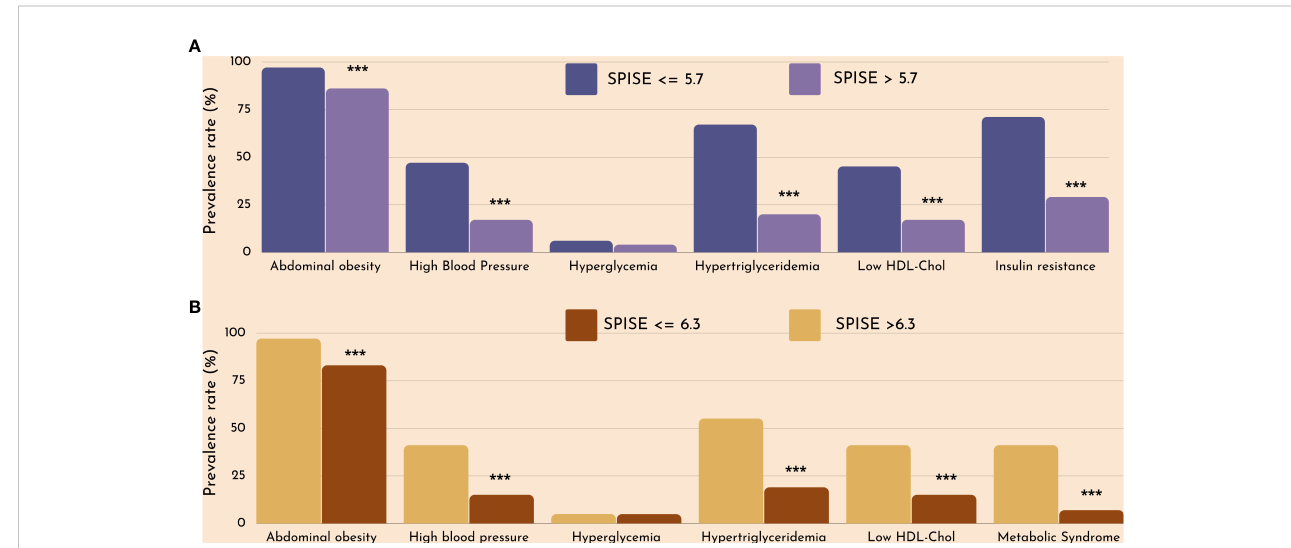
FIGURE 2 Cardiometabolic risk in obese children according to optimal SPISE cutoffs for MetS (A) and IR (B) screening. MetS and components diagnosed with the Cook et al. phenotype. Insulin Resistance de fi ned as having HOMA-IR ≥ 2.1 (Tanner 1-2). Pearson ’ s c 2 test: ***Signi fi cance at a